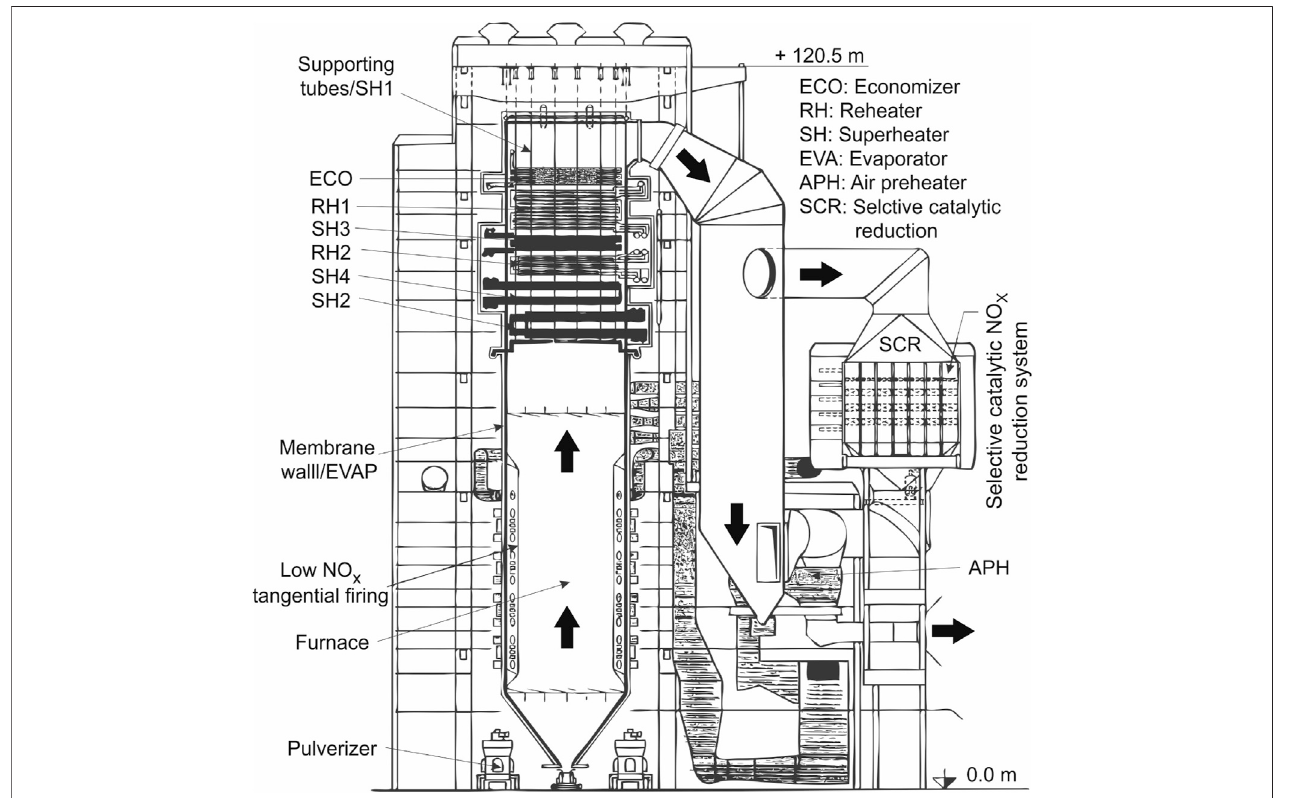
FIGURE 2 | Schematic diagram of a hard-coal fi red power plant (source Starkloff et al., 2015).